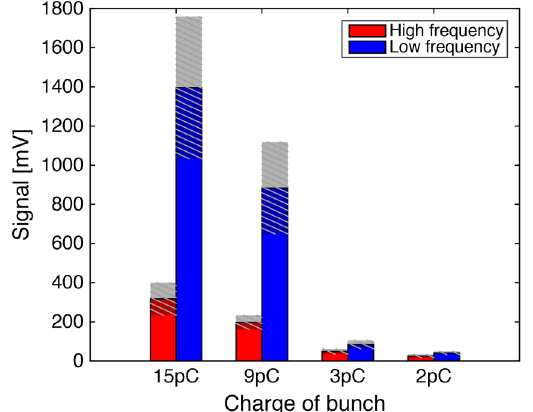
FIG. 9. The measured bolometer signal with low frequency filter and high frequency filter under different charges. The shaded area denotes the standard